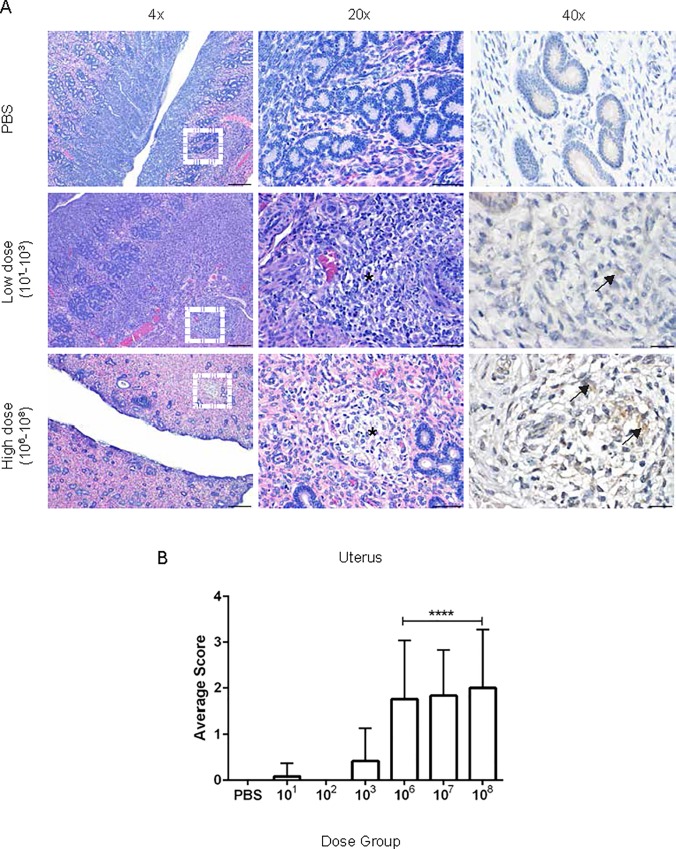
Histopathology of the uterus following Brucella infection.(A) Representative images of histopathology and immunohistochemistry of the uterus following intratracheal inoculation with PBS (top), B. melitensis 16M at low dose (middle), or high dose (bottom) at 30-days post-inoculation. (B) Sections were scored for severity from 1–4 (S1 Table) based on edema, endometrial neutrophilic inflammation, and myometrial inflammation. The white dashed box in the left panel indicates the section highlighted for higher magnification in the middle and right panels. The high dose group had increased numbers of neutrophils in the endometrium, foci of histiocytic inflammation within the myometrium (*), and Brucella antigen was detected intracellularly via IHC (arrows). Magnification 4x (left, H&E, bar = 200 μm), 20x (middle, H&E, bar = 50 μm), 40x (right, Anti-Brucella IHC, bar = 20 μm).